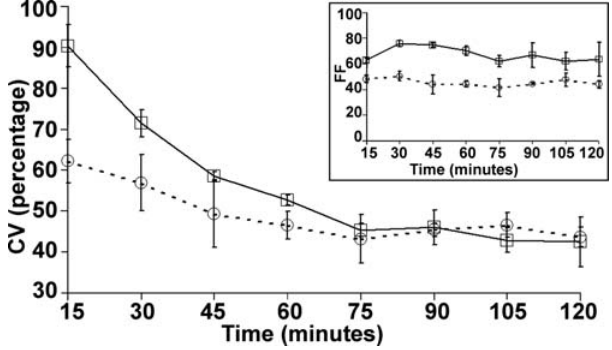
Figure 9. Comparison of Coefficient of Variation (CV) of experimental GFP distributions: Basic (TG- dashed line with circle ) and Delay (C2TG- solid line with square ) circuits. Inset: Changes in the Fano Factor (FF) for both the circuits. Error bars are of one standard deviation from three experiments.